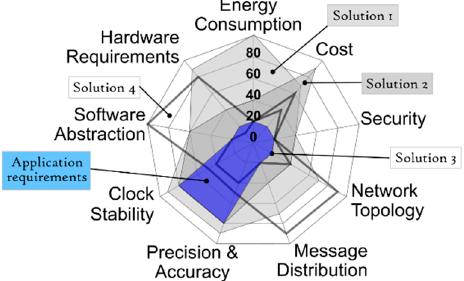
Figure 5. Graphical representation of how a valid solution is selected. Here the application requirements shape (blue area) is superimposed over all the available solutions in the database. Only the solutions 1 and 2 are valid (grey area) because they fully contain the area of this specific application requirements.